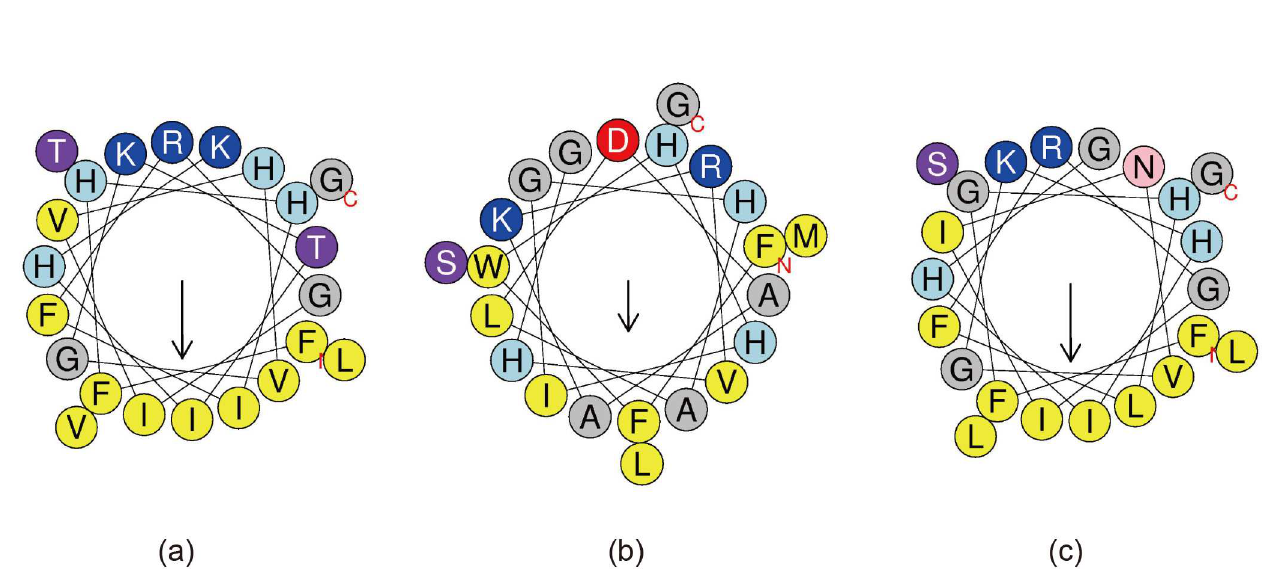
Fig 3. Helical wheel diagram depicting amphipathic alpha-helical conformations of (a) moro (b) moroNC, and (c) moroPC. Hydrophobic residues are yellow, positivelychargedresidues are blue, and negatively chargedresidues are red. Particularpolar residuesare violet (threonine and serine), pink (asparagineand glutamine) or sky blue (histidine).The arrows represent the helicalhydrophobicmoment.